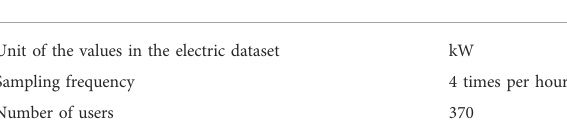
TABLE 3 Details of the subset of the electric dataset of the UCI